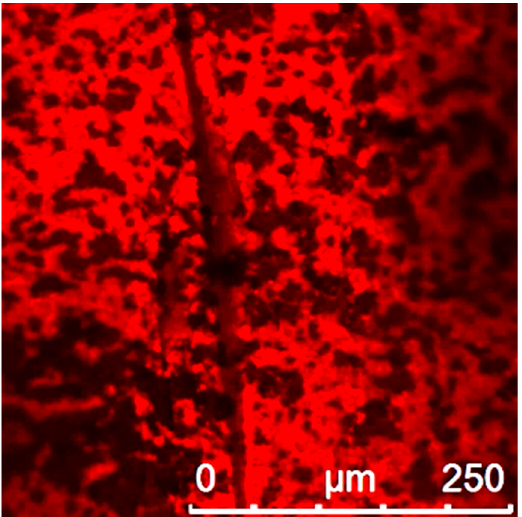
Figure 4. Confocal microscopy image of a hybrid membrane with the last layer of poly(styrenesulfonate) (PSS)-rhodamine 70 K. Voltage used for the photomultiplier tube (PMT)—700 V.